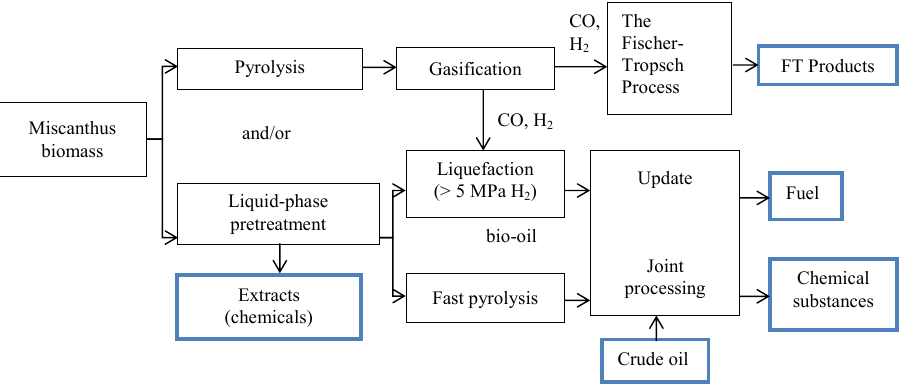
Figure 4 Simplified scheme of fuel and chemicals